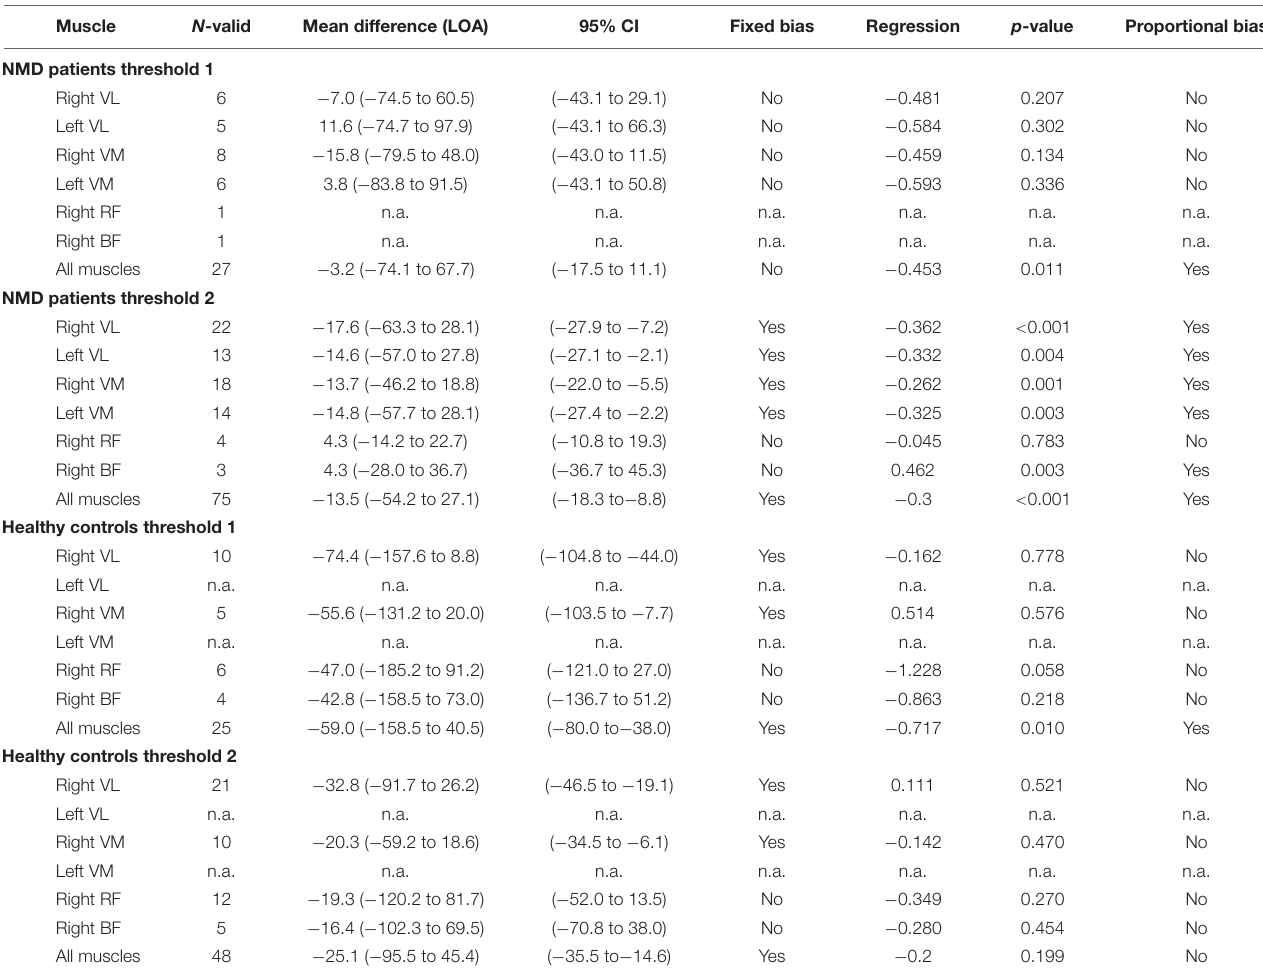
TABLE 5 | Analysis of the relation between the ventilatory and the sEMG thresholds. Muscle Mean difference (LOA) 95% CI Fixed bias Regression p -value Proportional